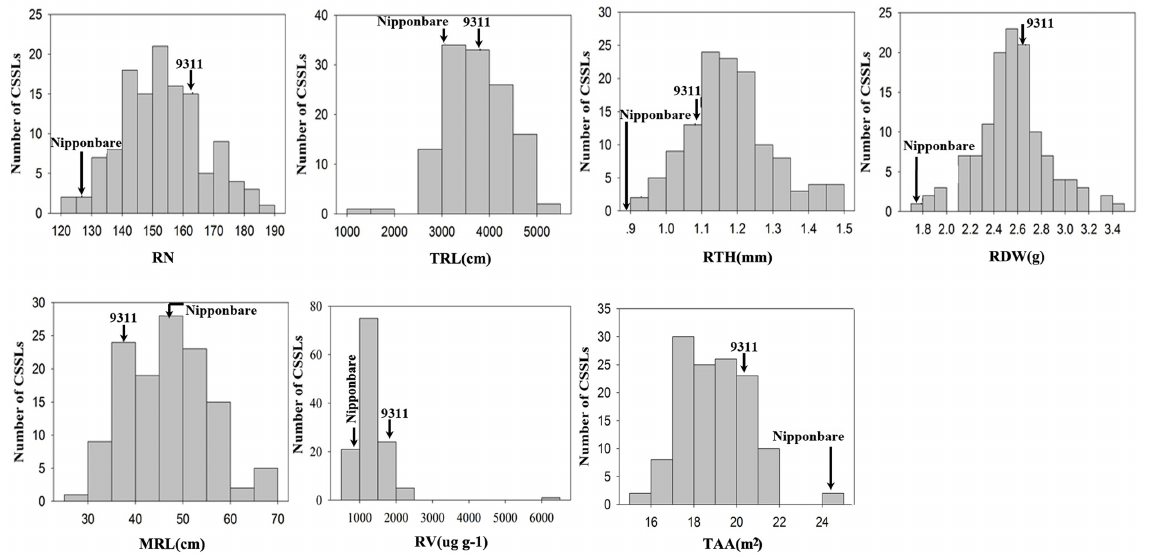
Fig 1. Distributions of chromosome segment substitution lines for the seven root